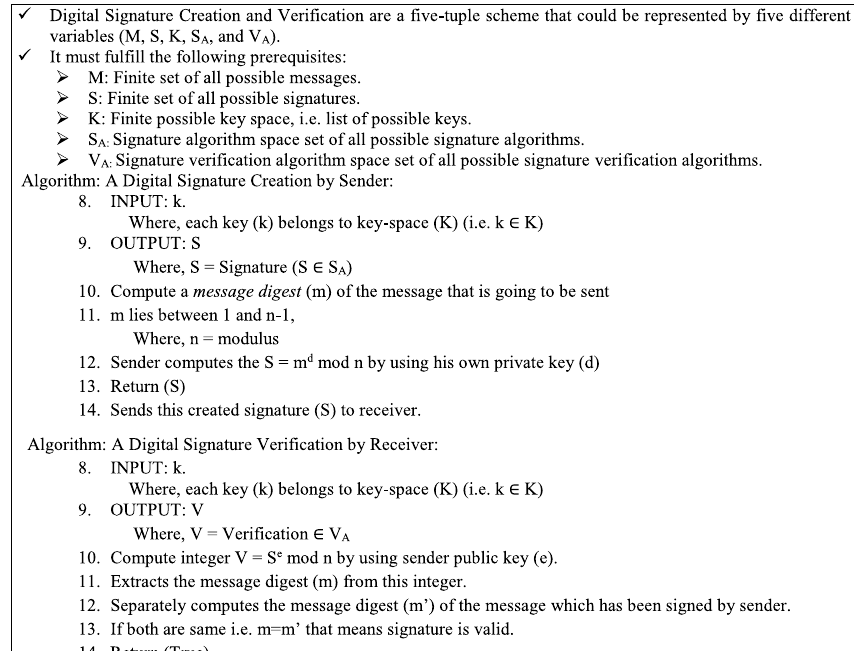
Table 3 Formal Way to Create and Verify Digital Signature